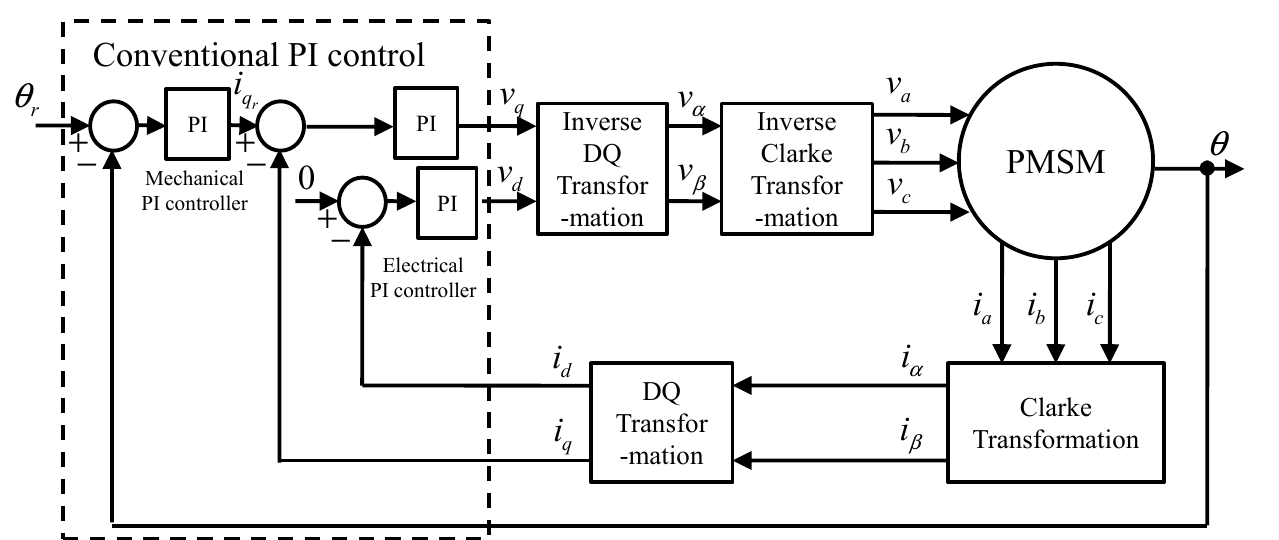
Figure 1. Block diagram of the general control method using DQ